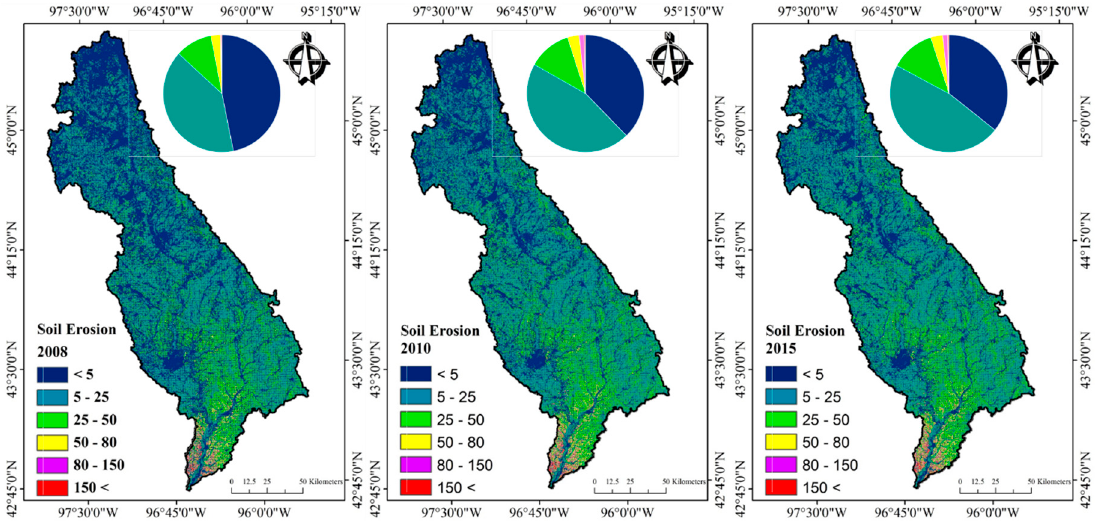
Figure 6. Soil erosion (T ha − 1 year − 1 ) estimated for the Big Sioux River Watershed for 2008, 2010, and 2015. Table 3. Correlation coe ffi cient of RUSLE parameters used for calculating the soil erosion at a watershed scale. R † K